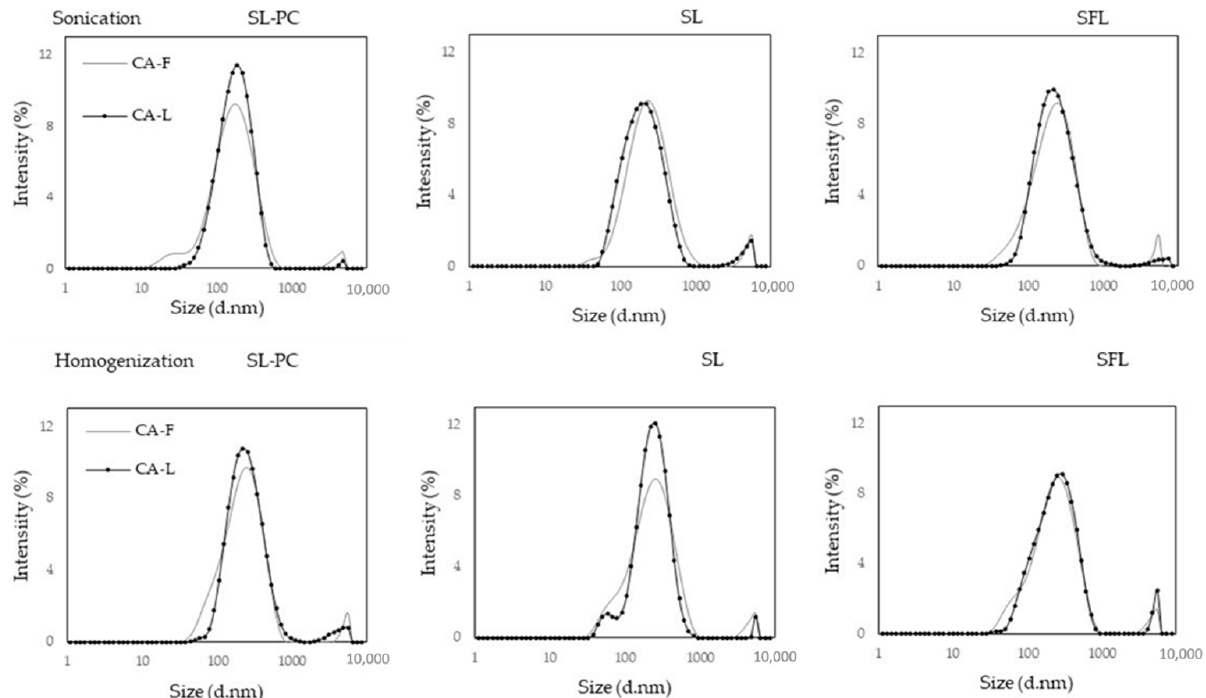
Figure 1. Particle size distribution of carvacrol-free (CA-F) and carvacrol-loaded liposomes (CA-L) (carvacrol–lecithin ratio CA:LEC: 1:1) using different lecithins and preparation methods. Table 1. Properties (hydrodynamic diameter (D H ), polydispersity index (PDI) and the ζ -potential ( ζ ) of liposomal systems obtained with the different types of lecithin (soy lecithin enriched in phosphatidylcholine (SL-PC), soy lecithin (SL) and sunflower lecithin (SFL)), using different carvacrol–lecithin ratios (CA:LEC: 0:1, 0.5:1, 1:1) and preparation methods (sonication and rotor– stator homogenisation).